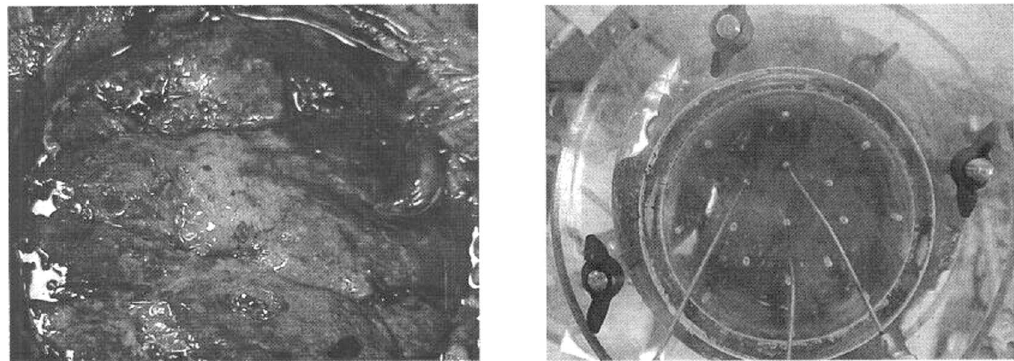
Figure 3. Maternal circulation. (a) Perfused cotyledon. (b) 18 gauge probes for maternal